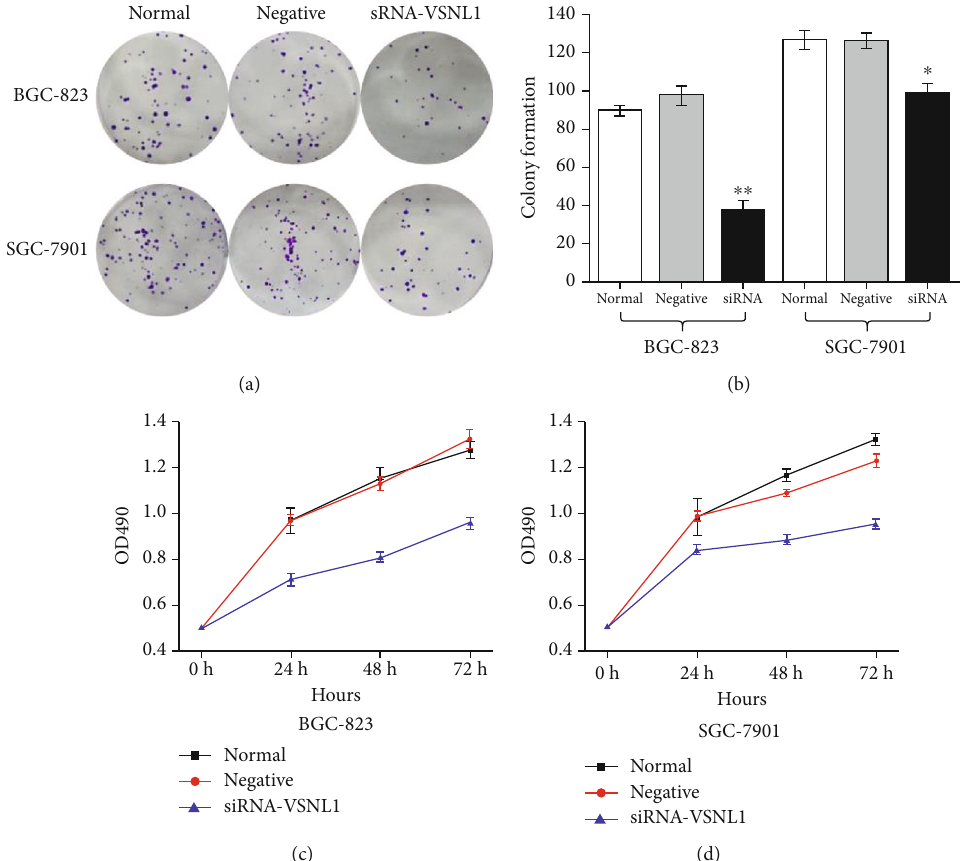
Figure 5: The e ff ect of VSNL1 on the proliferation of GC cells in vitro. We repeated each experiment three times. (a, b) Colony formation capacity was reduced following VSNL1 silencing ( p < 0 : 05 ). (c, d) Downregulation of VSNL1 expression inhibited the proliferative ability of BGC-823 and SGC-7901 cells compared with negative control and normal control cells ( p < 0 : 05 ).